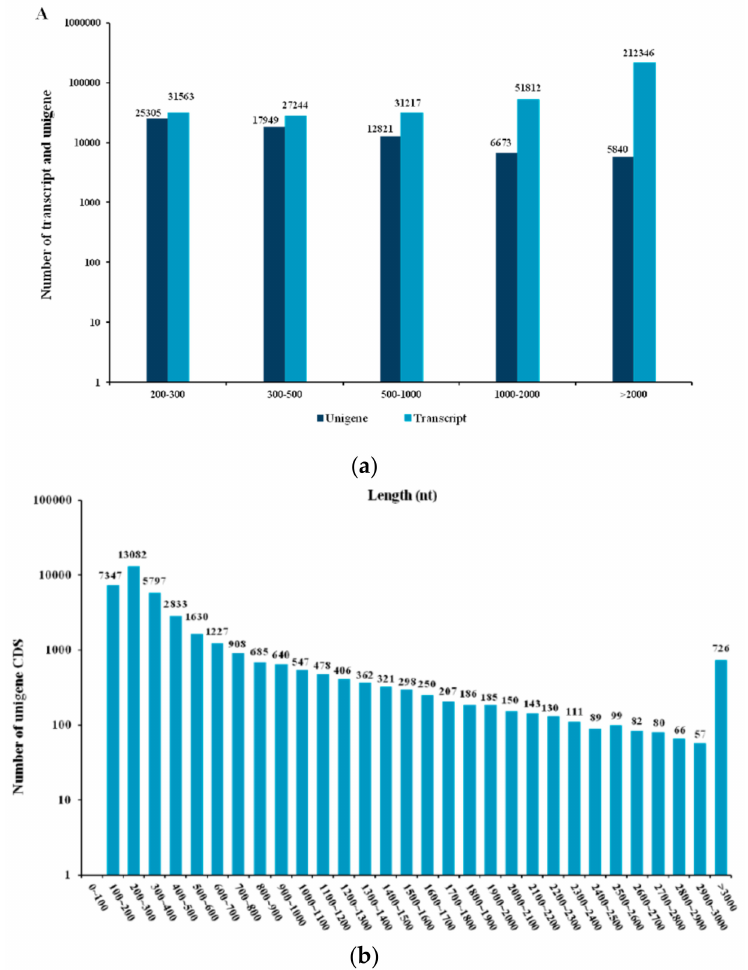
Figure 1. The size distribution of assembled unigenes of the Taenia pisiformis transcriptome: ( a ) Length distribution of transcripts and unigenes and ( b ) length distribution of unigenes coding sequences (CDS). Nt: